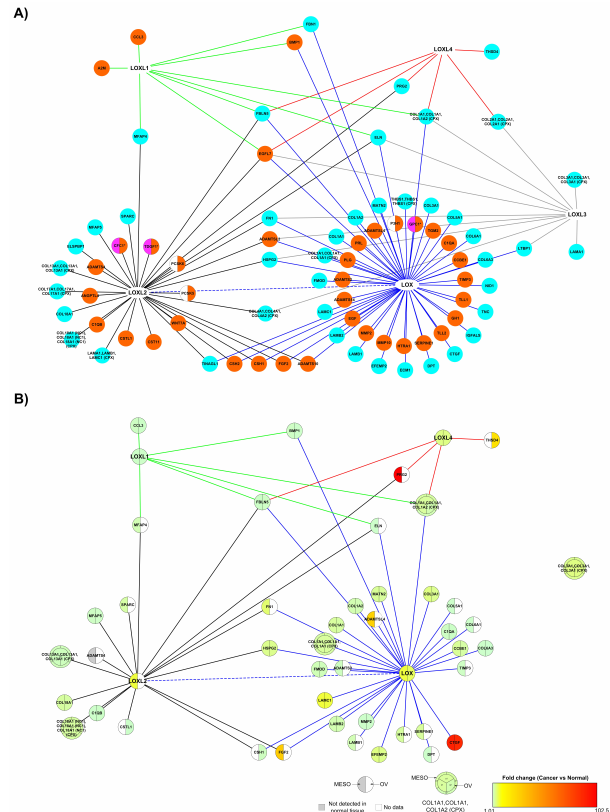
Figure 10. Matrisome-specific interactome of the LOX family. ( A ) Global matrisome-specific interactome of the LOX family. Proteins represented by nodes were color-coded according to their cellular location(s) determined by the Gene Ontology term “Cellular Component” (Supplementary Table S3): cyan: core-matrisome proteins, orange: matrisome-associated proteins, pink: membrane proteins. ( B ) Matrisome-specific interactome of the LOX family in mesothelioma (MESO) and ovarian serous cystadenocarcinoma (OV). Nodes were color-coded using the fold change values calculated in cancer (MESO and OV) versus normal patients in Izzi et al. [53]. Interactions, represented by edges, were color-coded according to the LOX family member they were connected to (blue edges: LOX interactions, green edges: LOXL1 interactions, black edges: LOXL2 interactions, grey edges: LOXL3 interactions, red edges: LOXL4 interactions, dotted blue edges: interactions between two members of the LOX family). Not detected: the expression level of ADAMTS4 was 0 in normal tissue, the fold-change was thus not calculated. No data: the gene is absent from Izzi et al. dataset